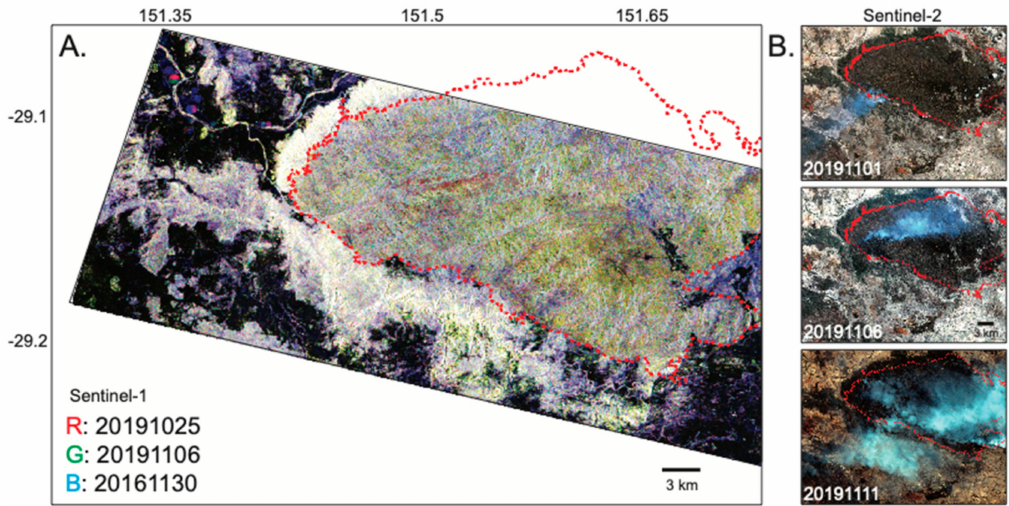
Figure 5. Observations of the Torrington fire, New South Wales, from Sentinel-1 imagery during November 2019. ( A ) RGB composite image utilising Sentinel-1 backscatter intensity imagery. The red line shows the extent of the burned area obtained from [48] with map product dated 20191113 and based on Landsat-8 data. ( B ) Sentinel-2 natural colour (RGB bands 4-3-2) optical images of the same